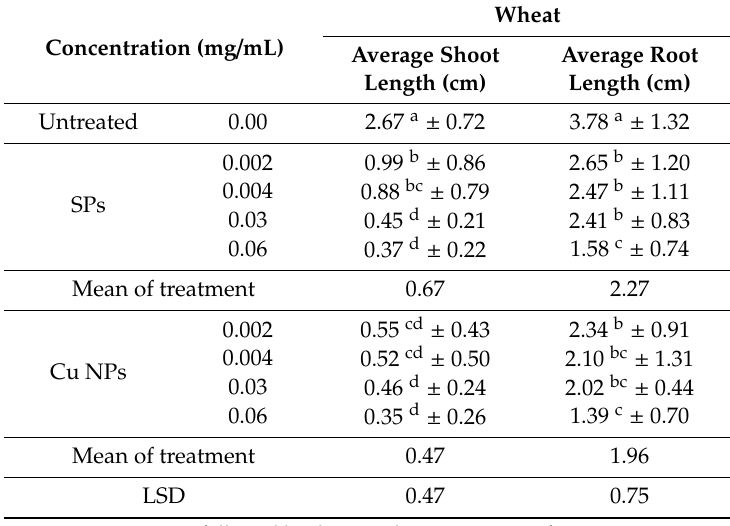
Table 2. E ff ect of SPs and Cu NPs on root and shoot lengths (cm) of wheat seedlings. Table 2. Effect of SPs and Cu NPs on root and shoot lengths (cm) of wheat seedlings. Concentration (mg / mL) Wheat Concentration (mg/mL)